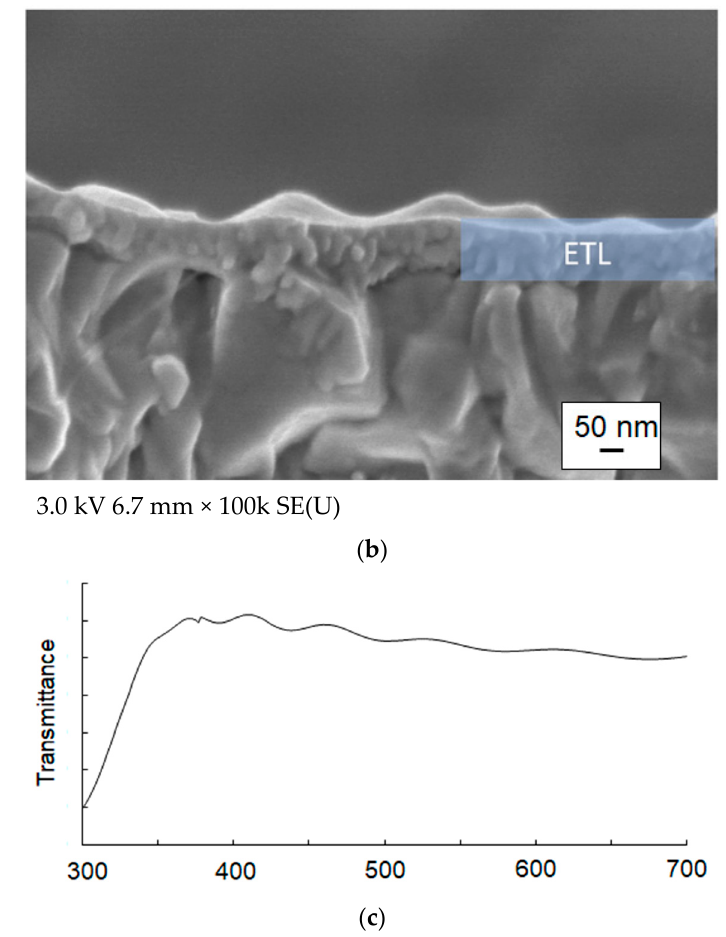
Figure 10. Cross-sectional SEM images of the best-performing device: ( a ) low-magnification image and ( b ) high-magnification image presenting the ETL part; ( c ) transmittance spectrum of the ETL thin film, which is the same sample as ( b ).